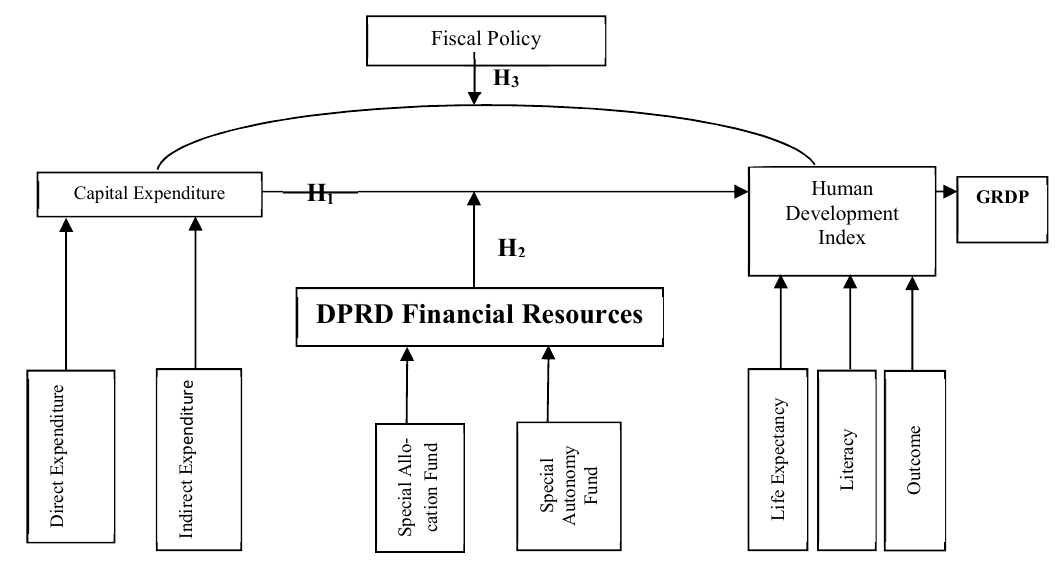
Fig. 1. Conceptual Model and